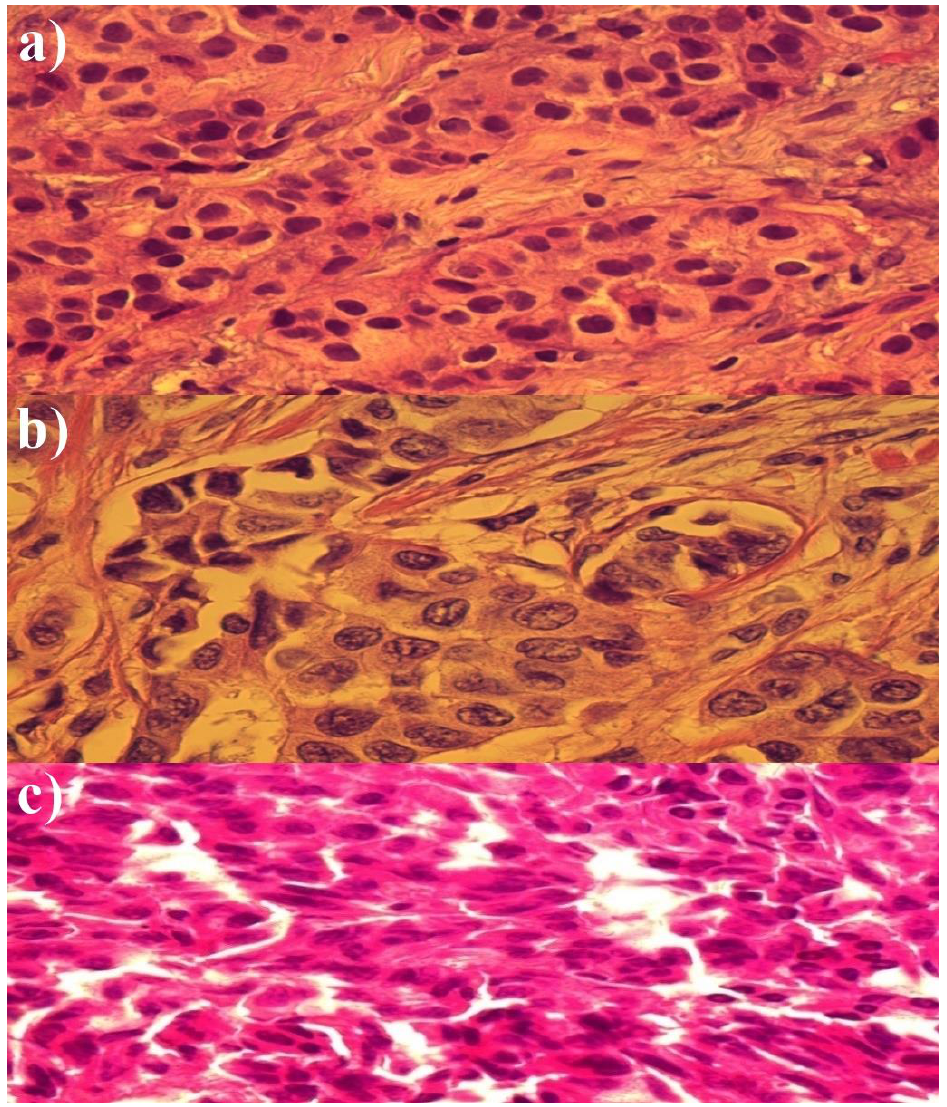
Figure 1. Image of histopathological material of cancer tissue ( a ) before chemotherapy and PDT, ( b ) after chemotherapy, ( c ) after chemotherapy and photodynamic action (Rose Bengal 0.02 g/mL).